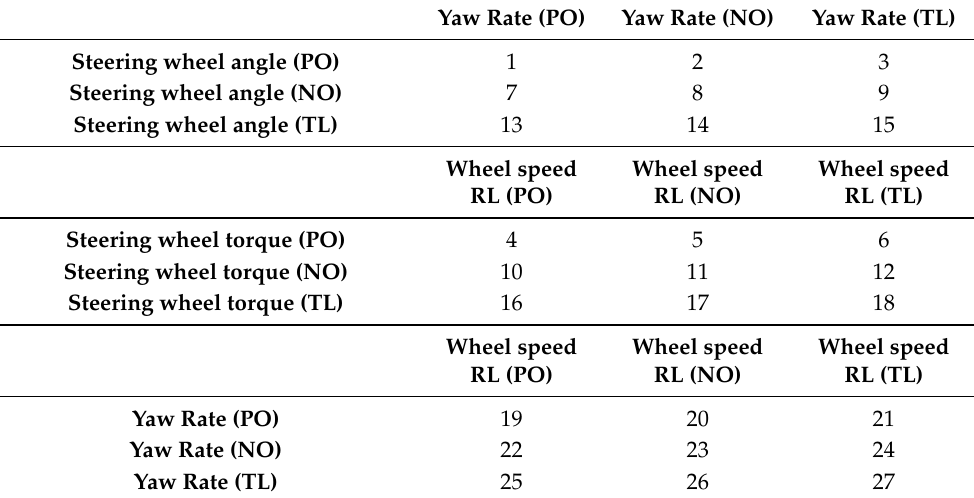
Table A2. Fault code for multi-sensor fault.